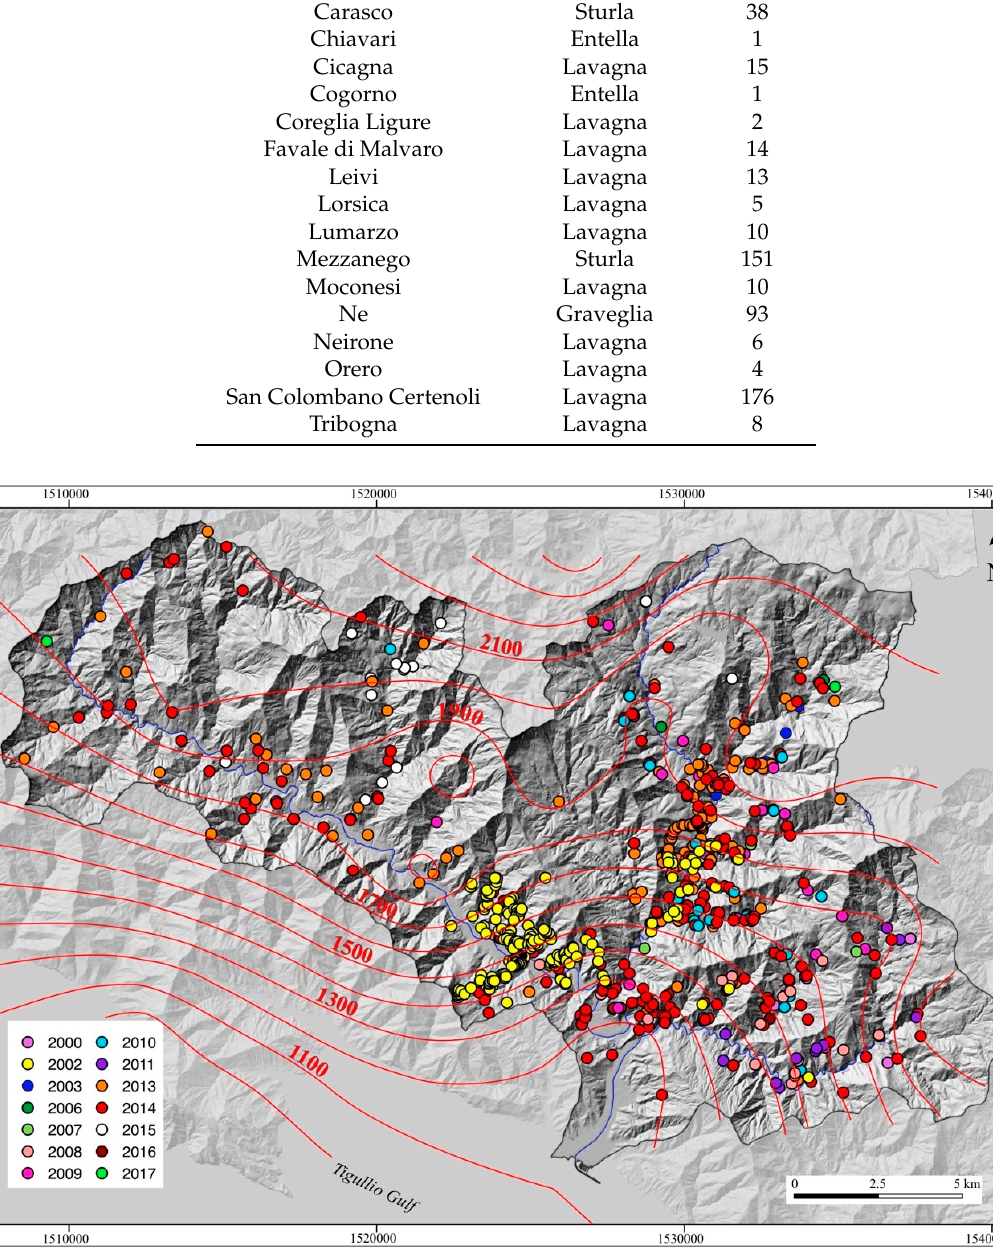
Figure 7. Spatial distribution of rainfall-induced shallow landslides which occurred in the Entella River basin over the period from 2000–2017. Red curves show the distribution of the mean annual precipitation in the catchment area.